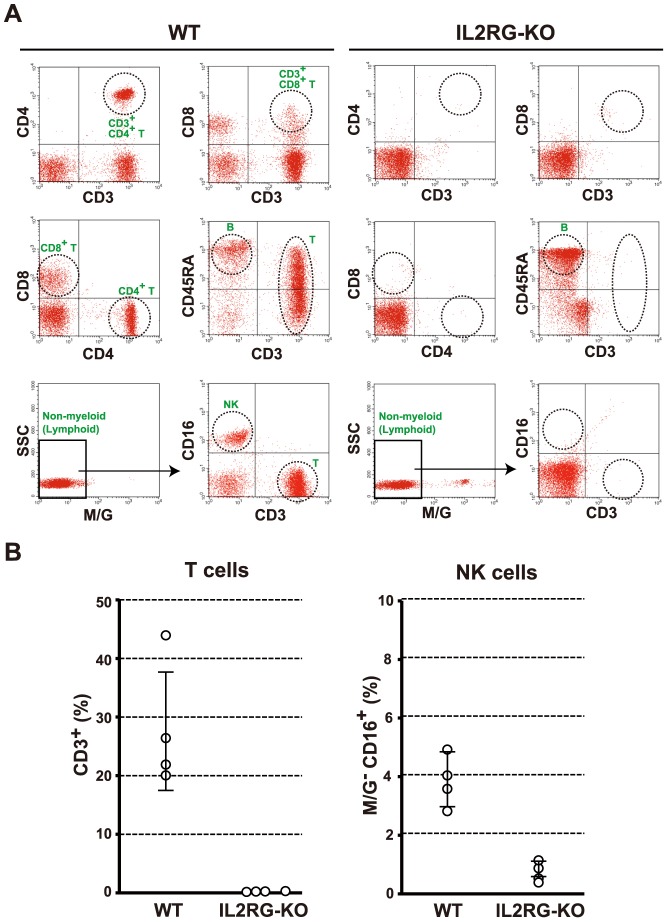
Flow cytometric analysis of mononuclear cells in IL2RG KO pigs.(A) Flow cytometric analysis of T, B, and NK cells in the peripheral blood of IL2RG KO pigs. The dot plots show CD3, CD4, and CD8 cells for the demarcation of T cell subpopulations and CD3, CD45RA, and CD16 (in the non-myeloid fraction, i.e., monocyte/granulocyte (M/G)-negative) cells for the differentiation of T cell, B cell, and NK cell subpopulations in the peripheral blood, respectively. (B) The proportion of T (CD3+) and NK (M/G−, CD3−, CD16+) cells among the mononuclear cells in the spleens of IL2RG KO pigs. The data represent the mean ± SD values of the 4 pigs obtained.